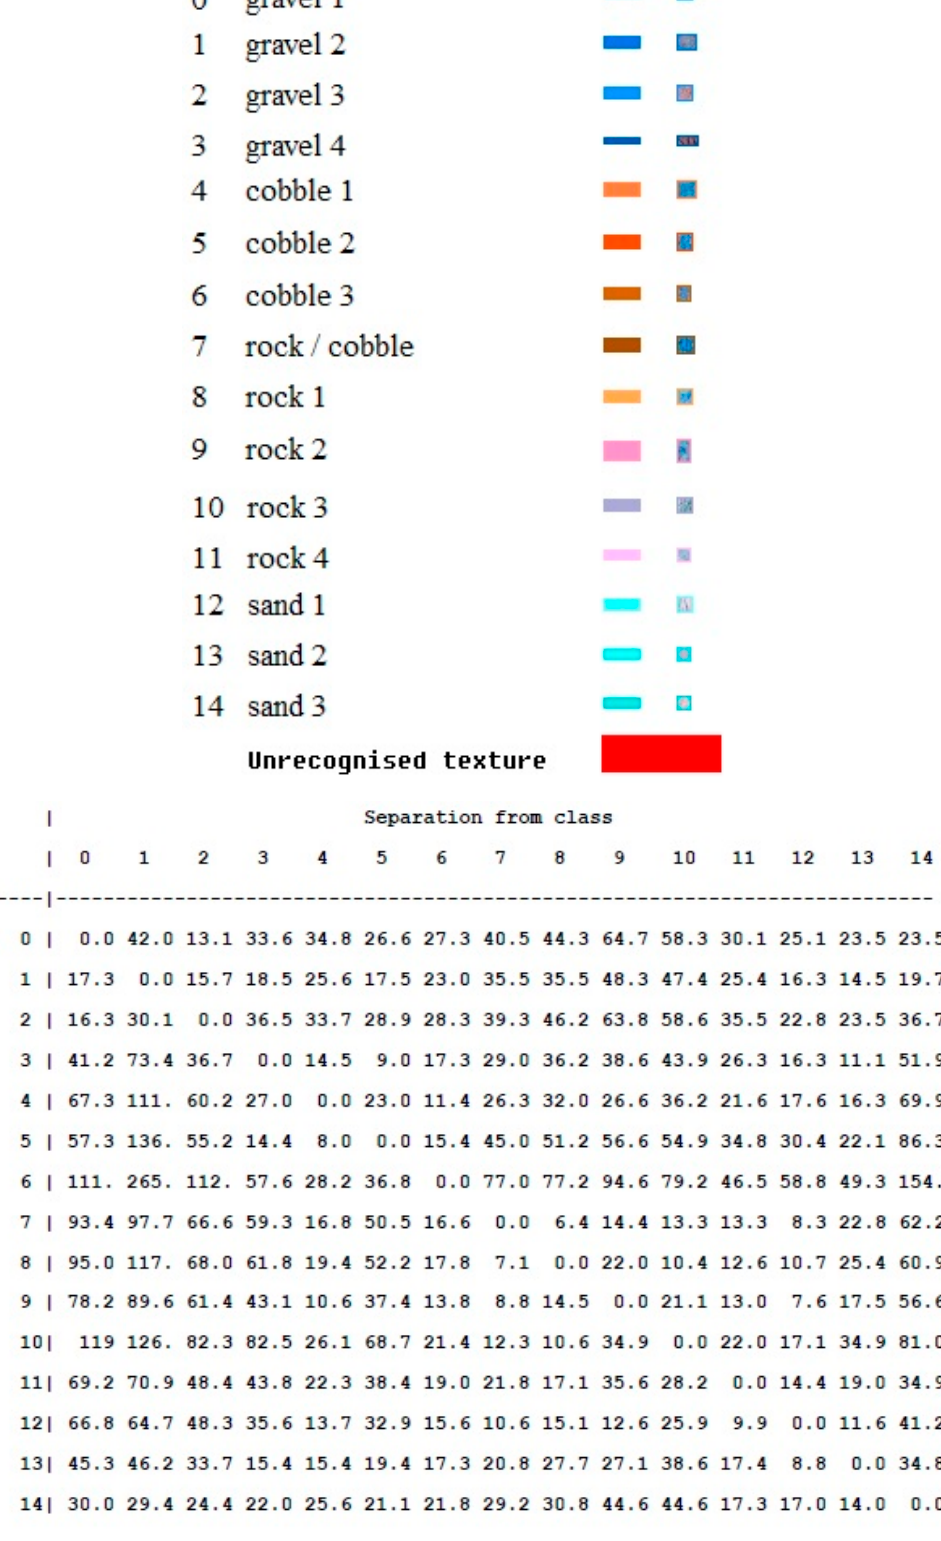
Table 1. Top: Seabed image textures selected from the three-frequency colour sonar image (Figure 2) during a user-supervised image texture characterisation process, subsequently used to generate the classified image (Figure 3). Bottom: A matrix of class separations (in standard deviations) computed for the image texture characteristics extracted from the three-frequency colour backscatter image.